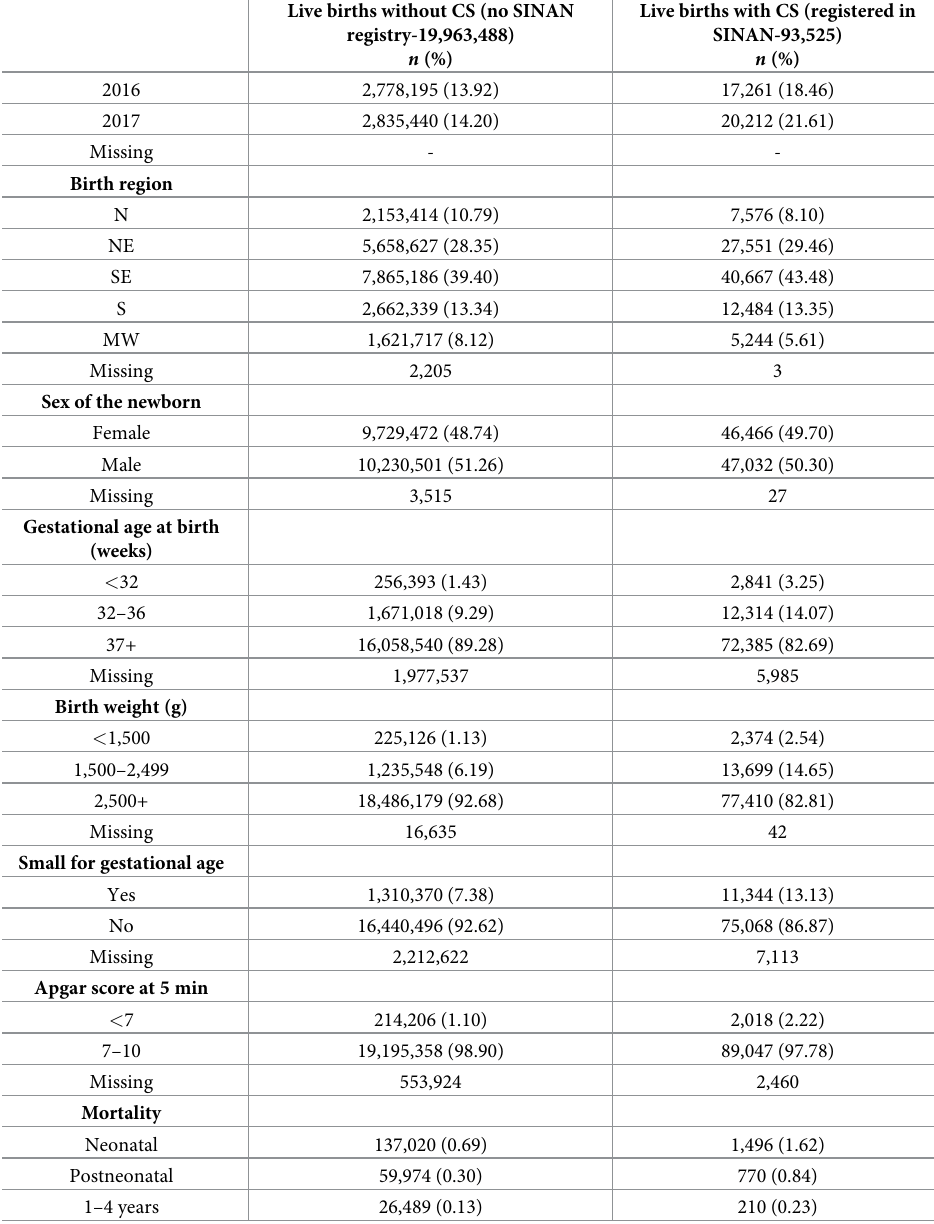
the 93 525 live-born children registered with CS had a higher proportion of younger, single black and mixed brown mothers with fewer years of education than the 19 963 488 children without CS registry. A total of 17 � 3% (15 155/87 540) of live birth children with CS were born preterm, 17 � 2% had low birth weight (16 073/93 483), and 13 � 1% (11 344/86 412) were small for gestational age compared with 10 � 7% (1 927 411/17 985 951), 7 � 3% (1 460 674/19 946 853), and 7 � 4% (1 310 370/17 750 866) among non-CS cases, respectively (Table